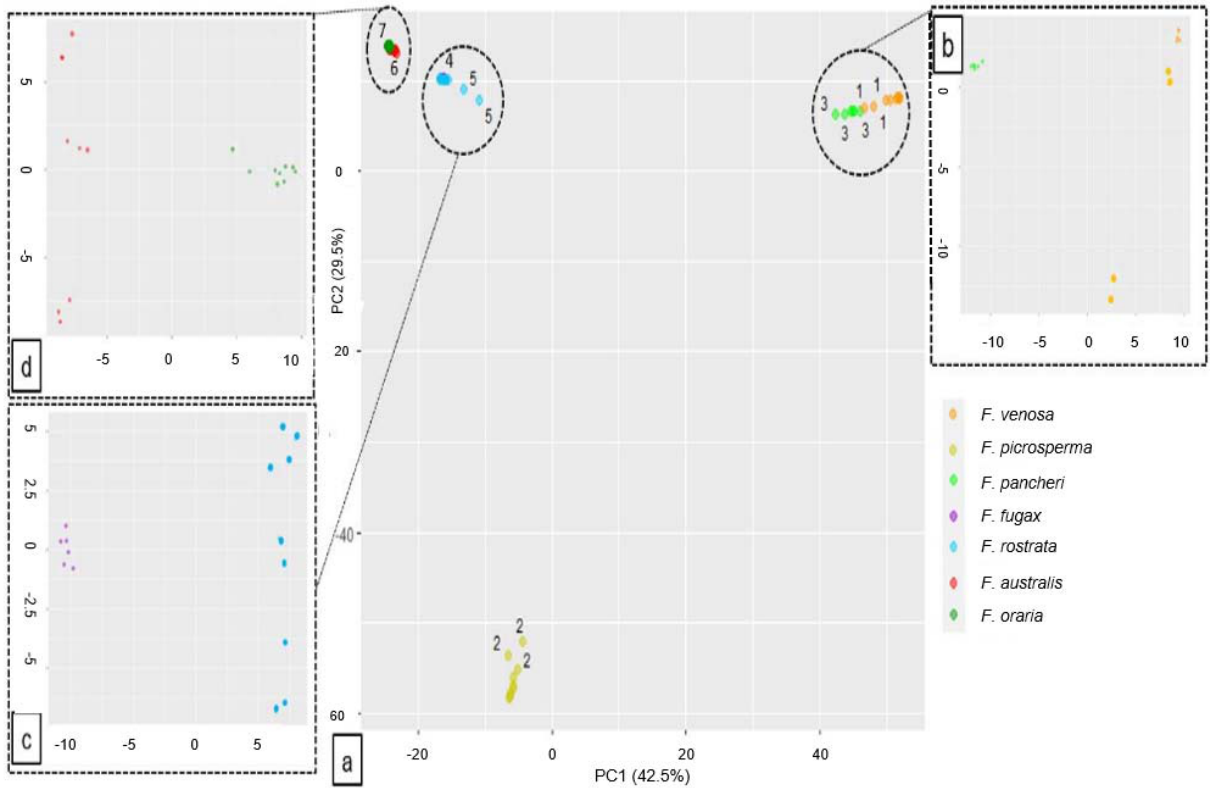
Figure 4. Principal component analysis (PCA) of the Fontainea genus from reduced-representation DArTseq SNP data ( a ) showing genetic grouping along axes 1 and 2. Inset PCAs represent the three putative genetic groups of sister species (( b ) F. venosa - F. pancheri , ( c ) F. fugax - F. rostrata , ( d ) Fontainea australis - F. oraria ) identified from phylogenetic analyses, which are magnified for clearer resolution of distribution of the closely grouped species along each respective axes. Table 2. Pairwise F ST matrix of the Austral-Pacific Fontainea complex from reduced-representation SNP data (5608 loci). Coloured boxes represent gradient level of genetic differentiation among each species. Gradient scale is indicated below table.